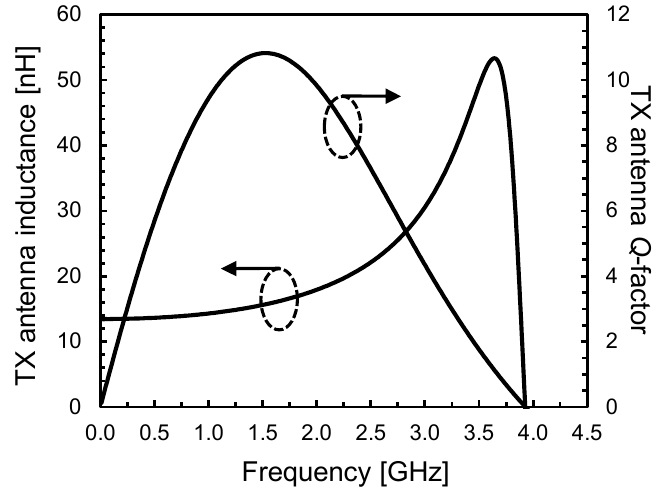
Figure 9. Inductance and Q -factor of the TX antenna as a function of frequency.